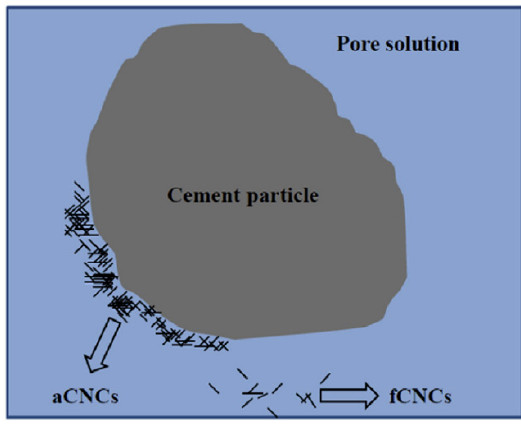
Figure 11. Schematic illustration of two different types of CNCs in cement paste. Reproduced from [58], with permission from Elsevier, 2016.